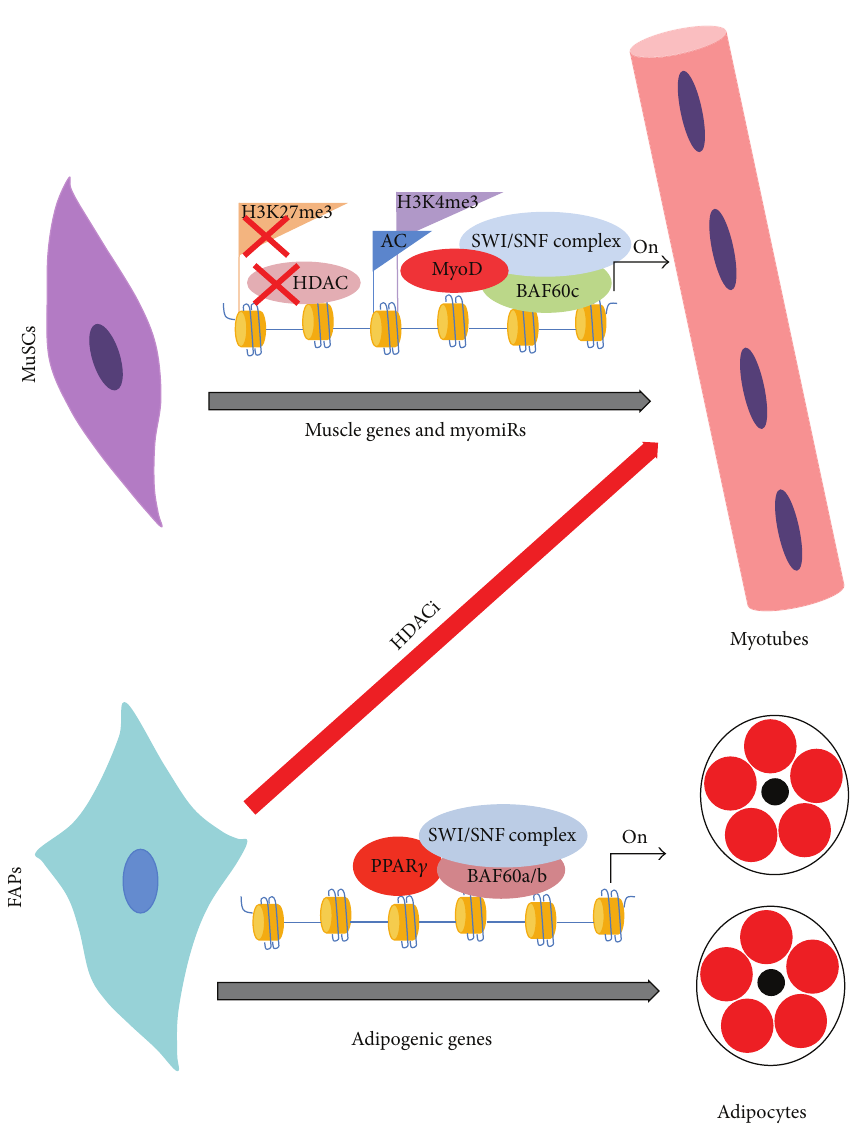
Figure 1: Epigenetic reprogramming of MuSCs and FAPs during differentiation. MuSCs adopt a chromatin permissive structure on muscle genes in which MyoD and BAF60c-based SWI/SNF complex promote transcription (on the top). FAPs differentiation into adipocytes is mediated by BAF60a/b-based SWI/SNF complex (on the bottom). HDACi treatment in dystrophic muscles activates a myomiR/MyoD/BAF60c network that, switching the BAF60 subunits assembled in the SWI/SNF complex, reprograms FAPs toward the acquisition of a myogenic